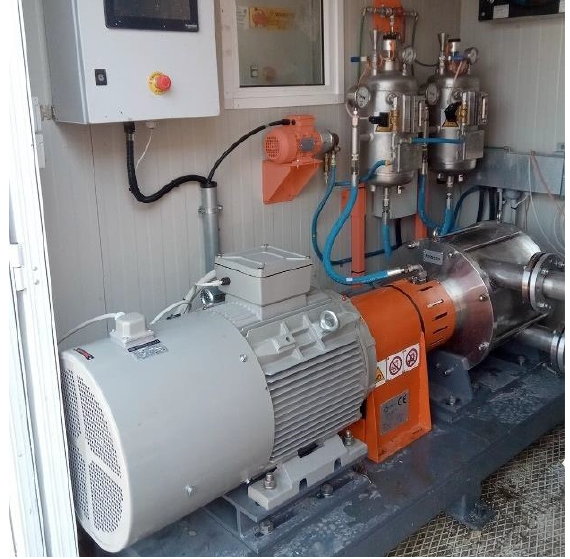
Figure 18. HC rotor stator devices for flowtrought biomass pretreatment in kg scale (max. flow rate 30000 L/h). E-PIC s.r.l. [115].